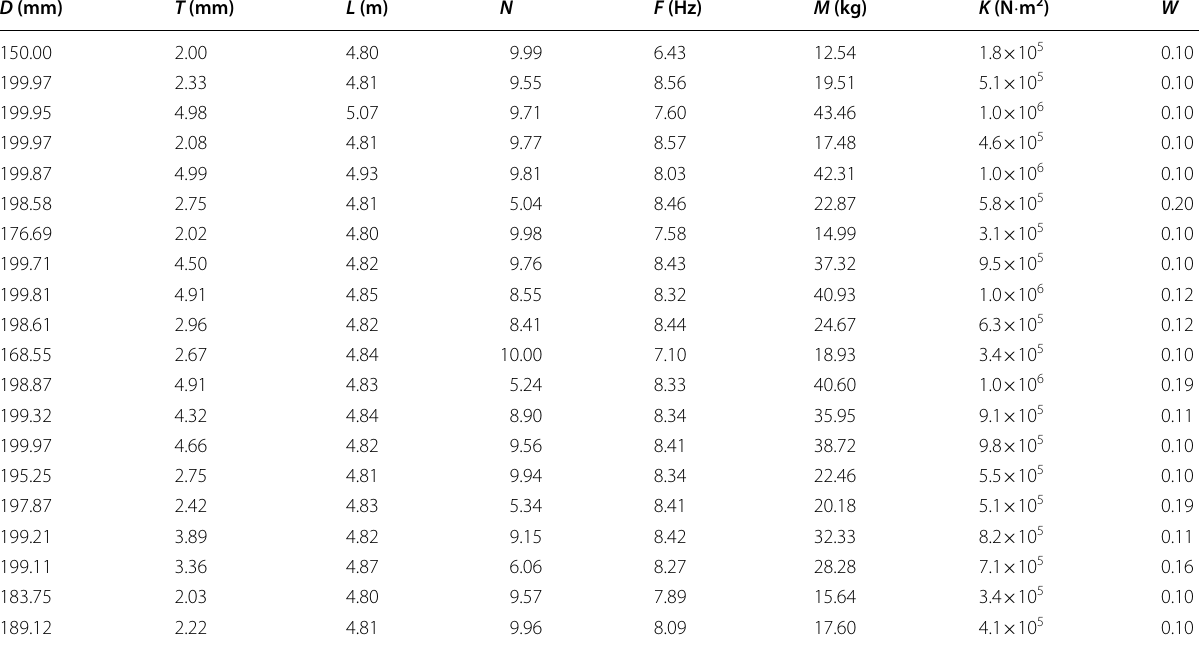
Table 9 Multiobjective optimization Pareto solution